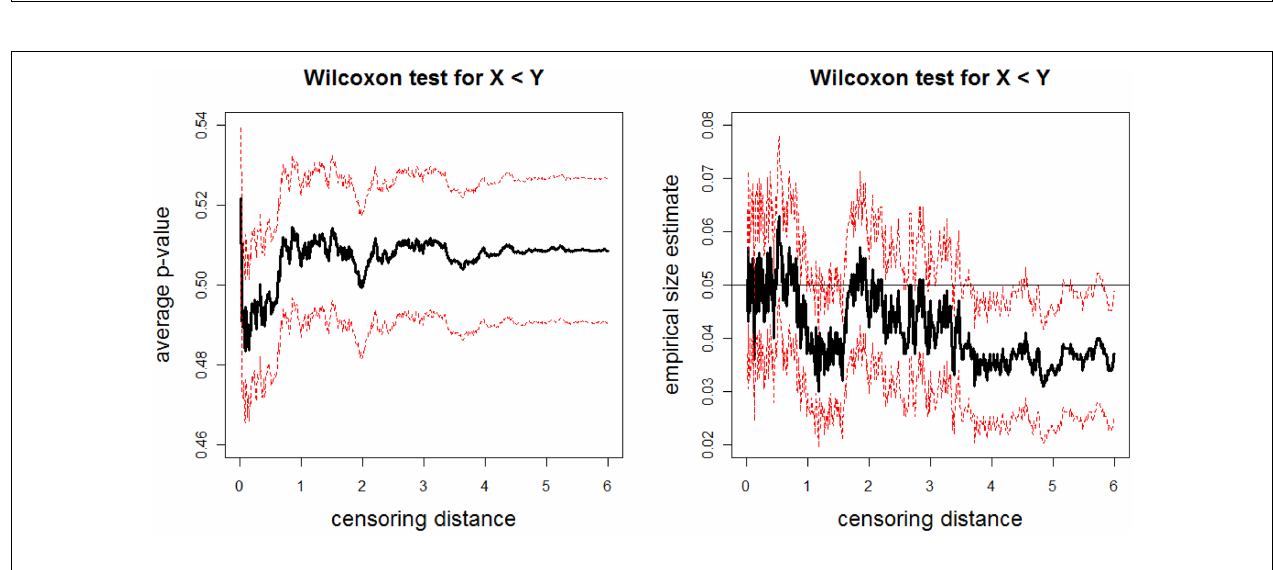
bands (dashed lines) are based on 1000 Monte Carlo replications under the null hypothesis of distributional equality of censored X and Z sets that are generated as described in Section “Simulation of realistic LCDM distances”. Horizontal line in the right plot is at